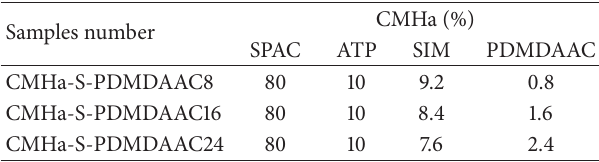
Table 9: The influence of different carrier materials on the coagula- tion behaviors of CMHa-S (1000NTU diatomite suspension).